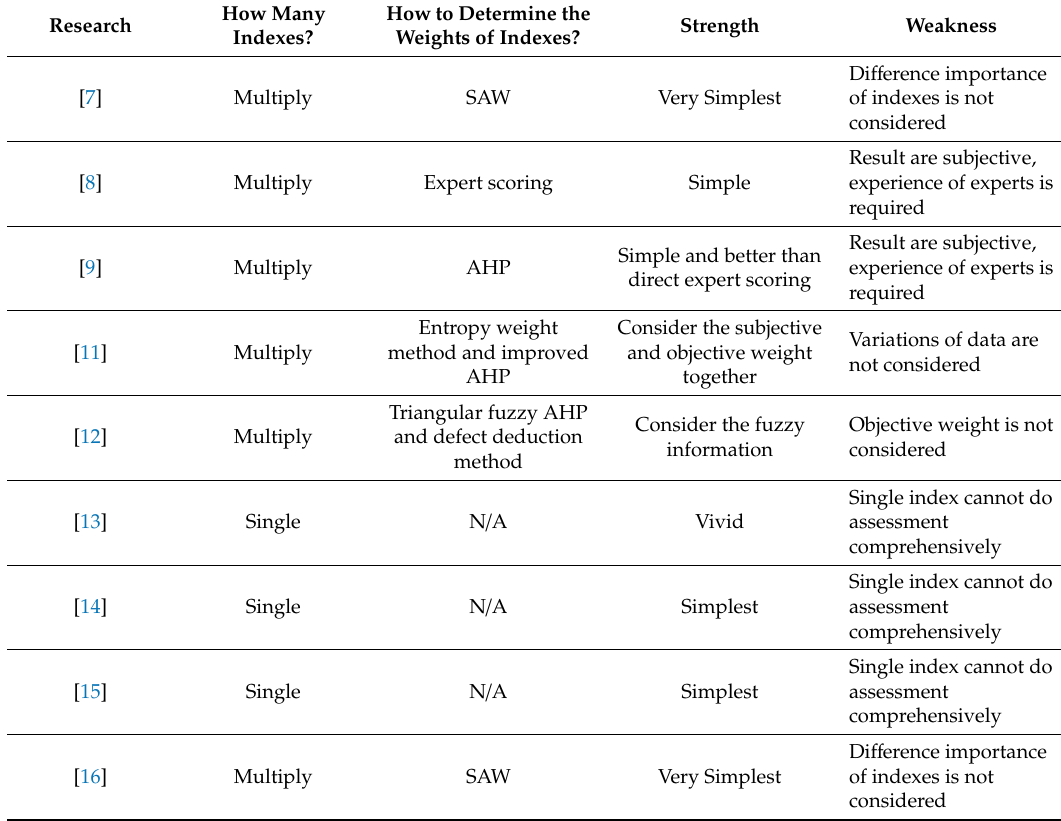
Table 1. Strengths and weaknesses of existing research about quality assessment of smart meters.